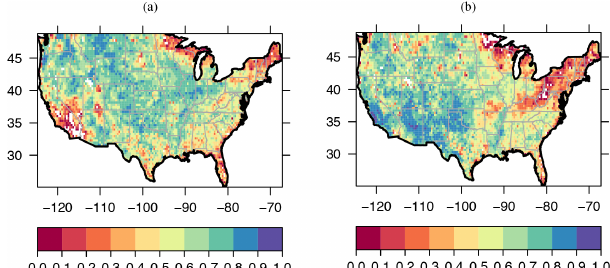
Figure 4. (a) Correlations ( R ) between VIC and SMAP beta mod- els for the warm season (average R = 0 . 57) and (b) cold season (average R = 0 . 56). White regions signify a negative